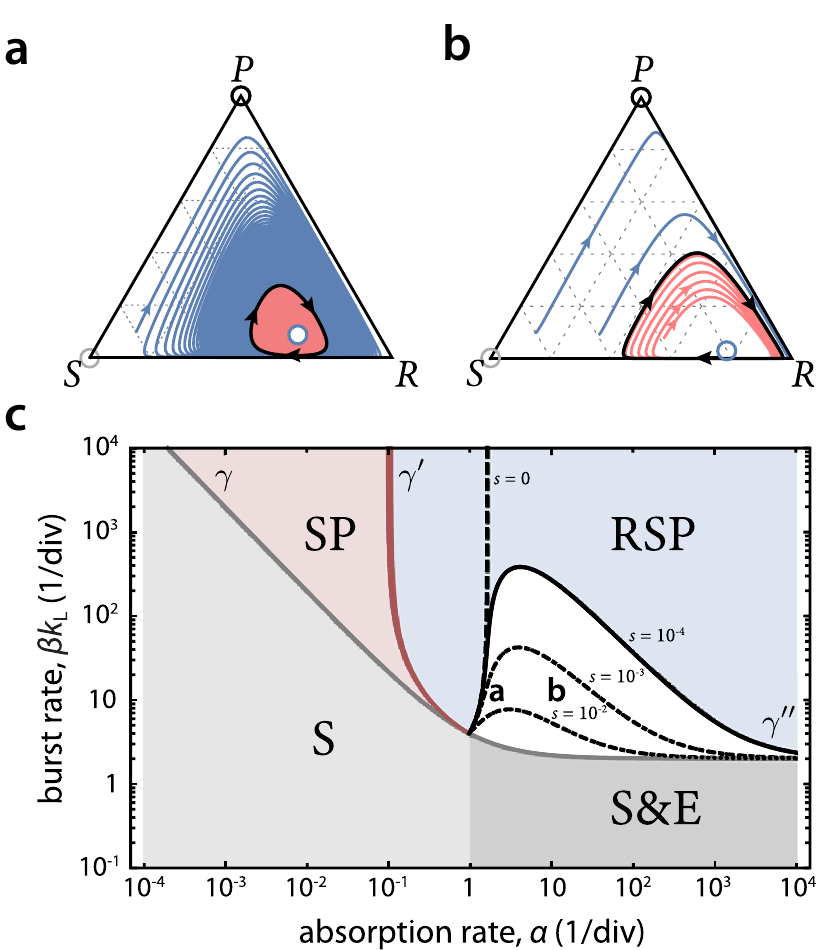
Fig. 3 Stable phases for immune defenses. ( a , b ) Flow diagrams of Eq. (3) applied to immune defenses show periodic orbits occurring in the RSP region of the phase diagram shown in panel c. Blue and pink curves show trajectories that approach the orbits from two directions. The blue empty circle marks the location of the unstable interior fi xed point. ( c ) Phase diagram for immune defenses. The S, SP, RSP and S&E phases are de fi ned as in Fig. 2. Curves γ (gray), γ 0 (dark red) and γ ″ (black) denote locations of bifurcations. The white region bounded by γ ″ (shown for s = 10 − 4 ) contains no stable fi xed points and exhibits a stable limit cycle. Dotted black curves denote the γ ″ curve for higher switching rates; the dashed black curve corresponds to γ ″ for s = 0. Letters a and b indicate approximate locations corresponding to the fl ow diagrams above (using s = 10 − 3 ). Remaining parameters are as in Fig.